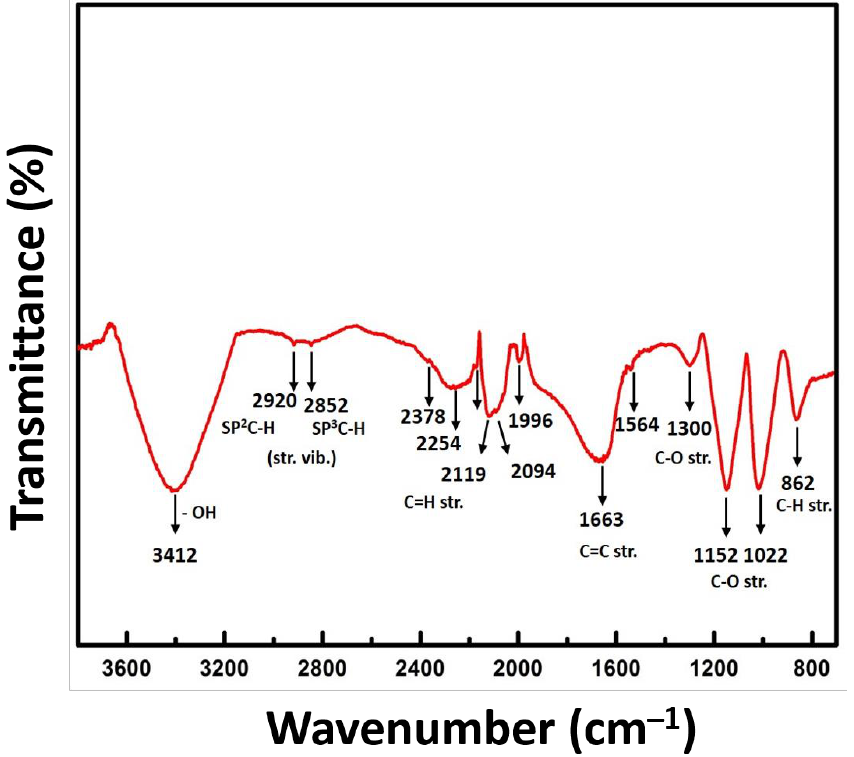
Figure 2. FTIR spectrum of